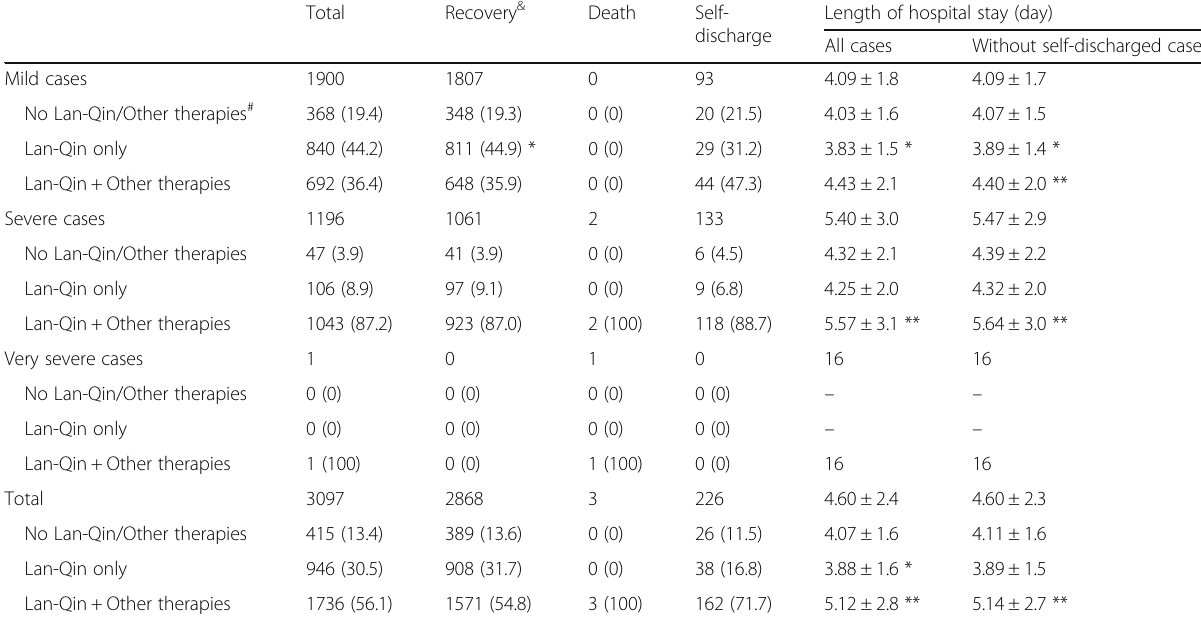
Table 2 Lan-Qin effect on the outcome of HFMD cases $ Total Recovery & Death Self-